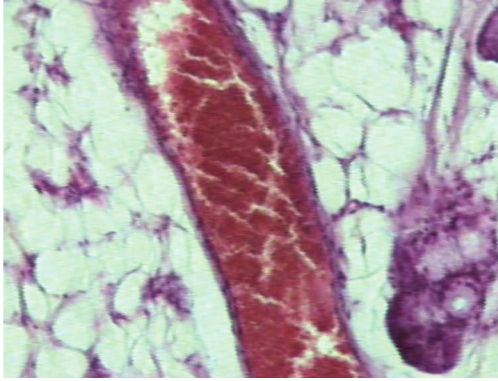
Figure 5: A thrombosed arteriole in the sagittal section. The fresh thrombus expanded longitudinally. There is evidence of adjacent cellular